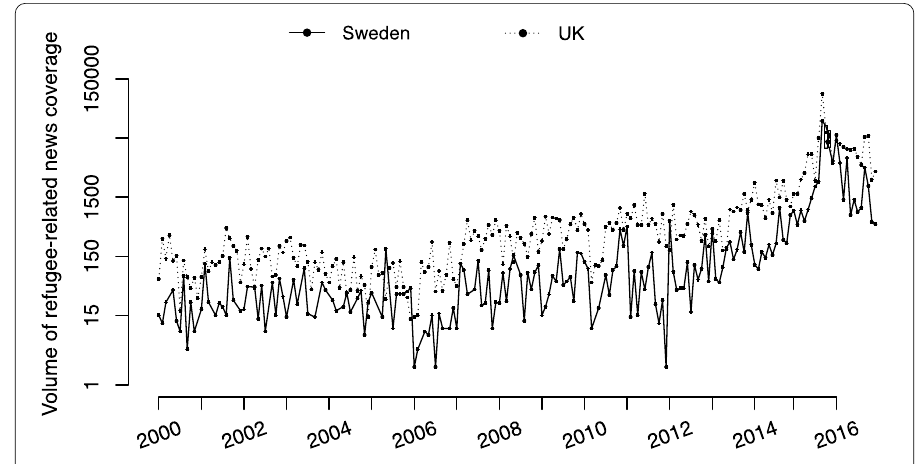
Figure 4 Time evolution of news volume on the European refugee crisis. The dotted and solid lines correspond to the number of times articles in GDELT mention refugee-related news events concerning the UK and Sweden, respectively, from